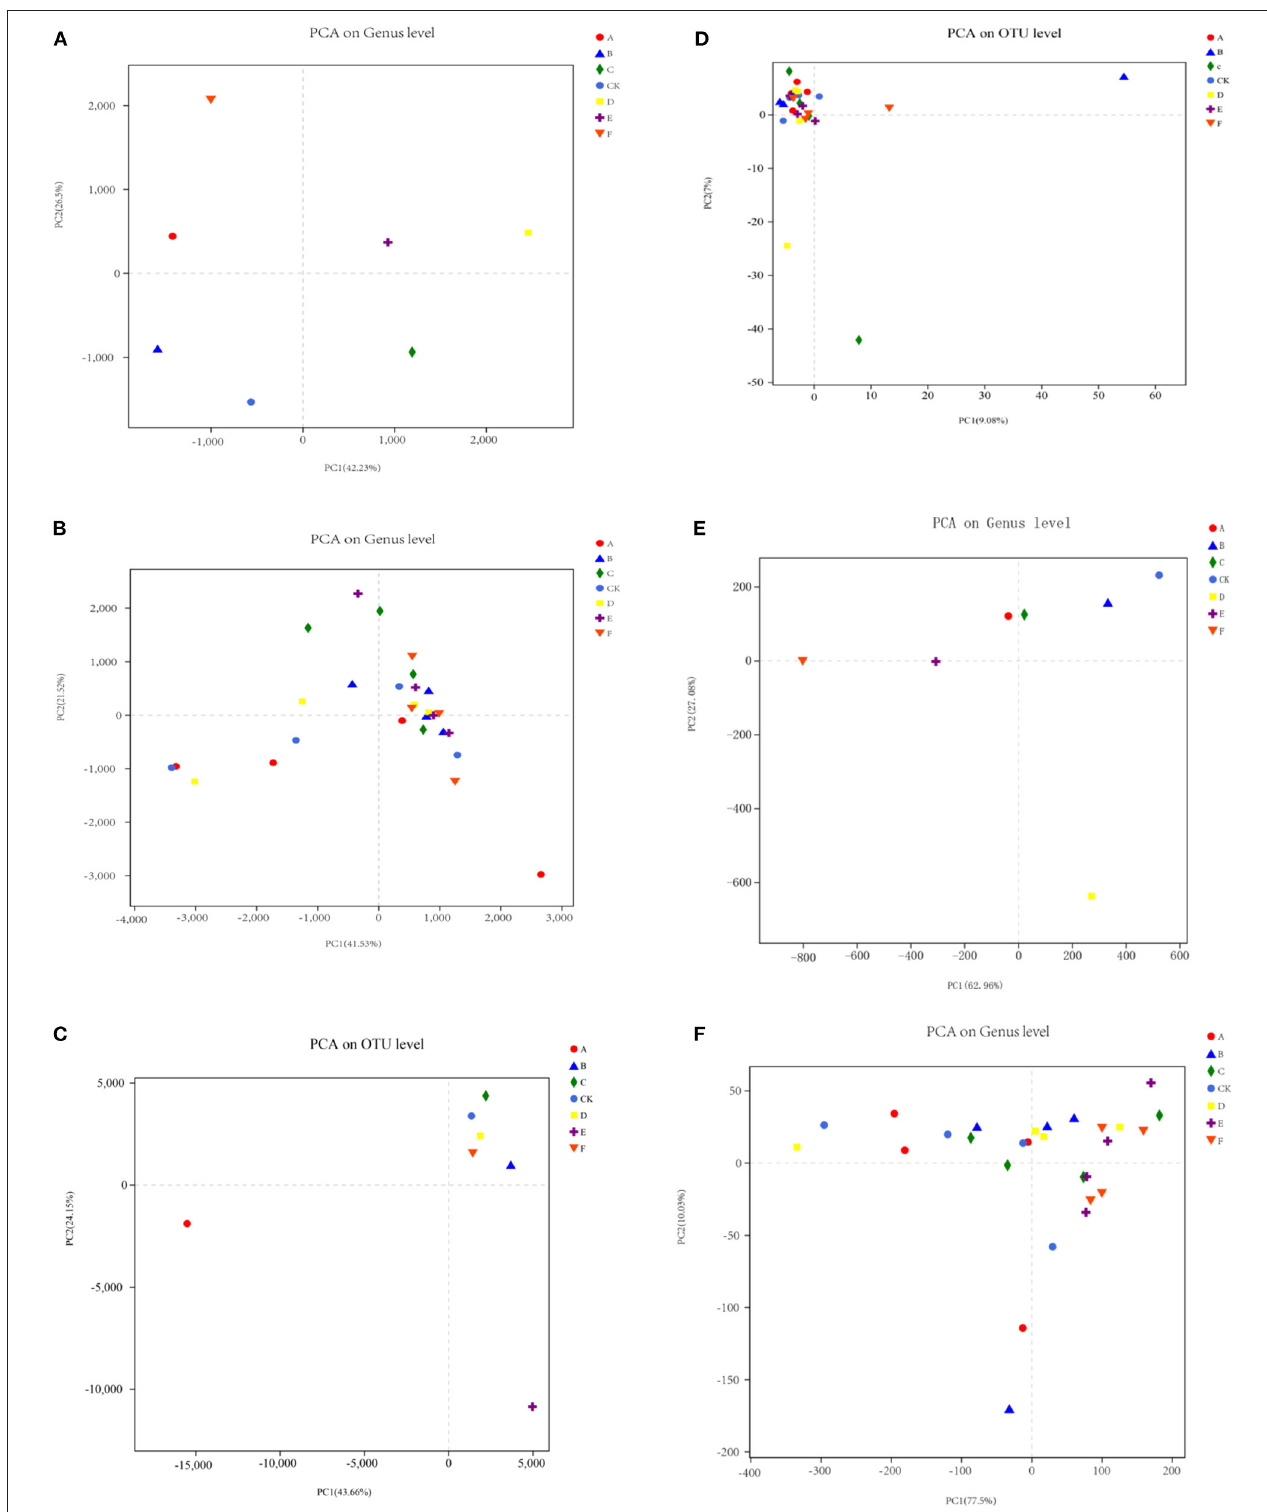
FIGURE 4 | Principal component analysis of the microbial community of the kiwifruit soil after sulfur treatment. (A,B) bacteria; (C,D) fungi; (E,F) actinomycetes.